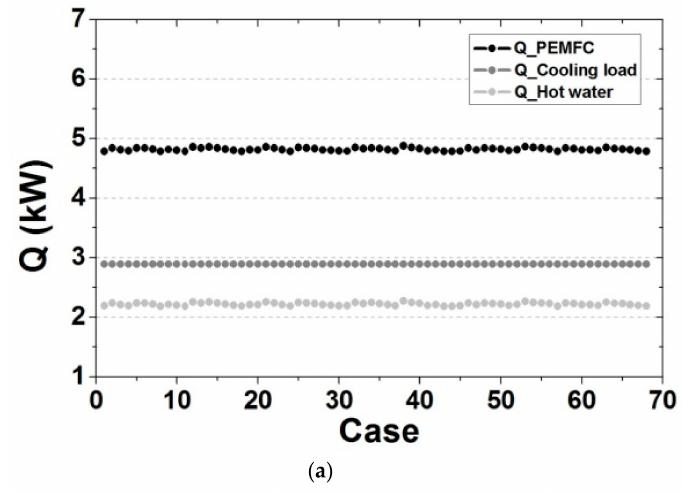
Figure 3. Comparison of PEMFC in / out TEG and hot water temperature by case according to absorption cooling performance. ( a ) Absorption cooling capacity: 1.5 kW; ( b ) Absorption cooling capacity: 2.0 kW; ( c ) Absorption cooling capacity: 2.5 kW; ( d ) Absorption cooling capacity: 3.0